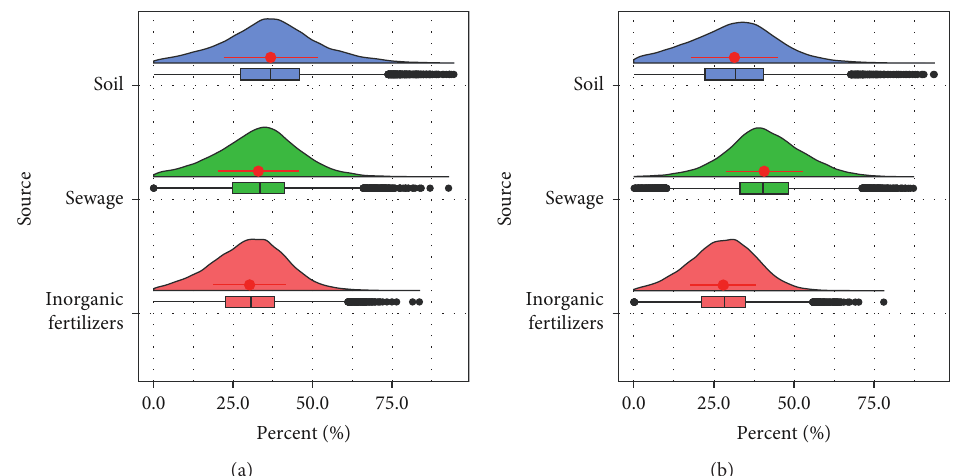
Figure 6: Posterior distribution of proportional contributions of three potential NO − period; (b) dry